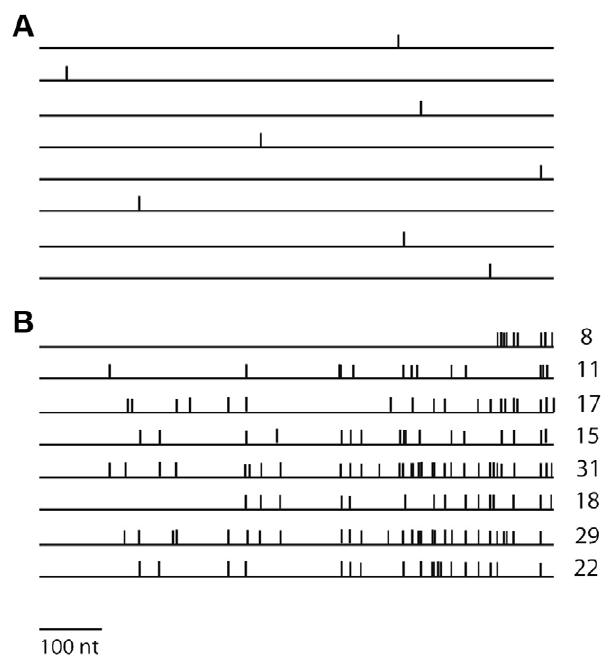
Figure 3. Comparison of mutations induced by A3G invitro and invivo . Schematic representation of examples of mutant ura3 alleles obtained upon A3G expression in yeast cells (a) and in vitro using gapped substrate (b). Horizontal lines represent the URA3 gene ORF; vertical bars indicate the approximate positions of base substitutions. Eight independent mutant clones are shown in (a) and eight in (b). The number of base substitutions per clone is shown on the right (b).